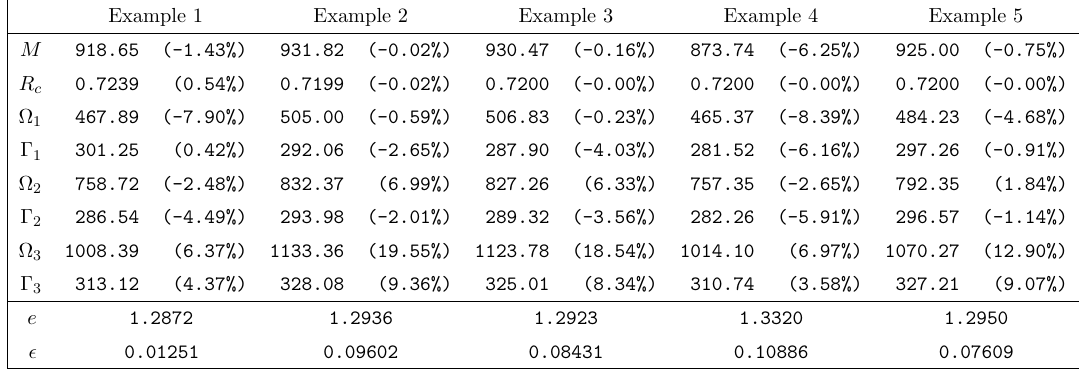
Table 4 . Values of observables of examples found from minimizing the function G , along with the relative deviations from the target values, together with the corresponding (cid:12)t values of the parameters e and (cid:15) .